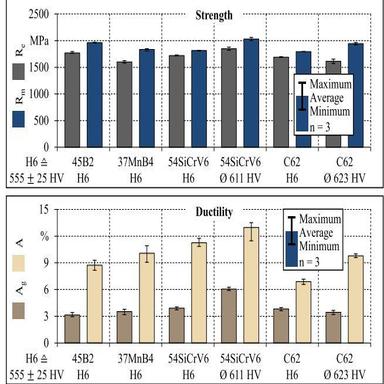
Mechanical properties of the examined wire materials for several material conditions.